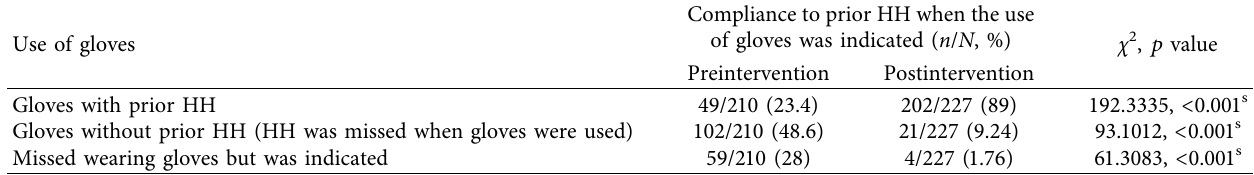
Table 3: Comparison of compliance to hand hygiene in patient contacts when gloves were used.